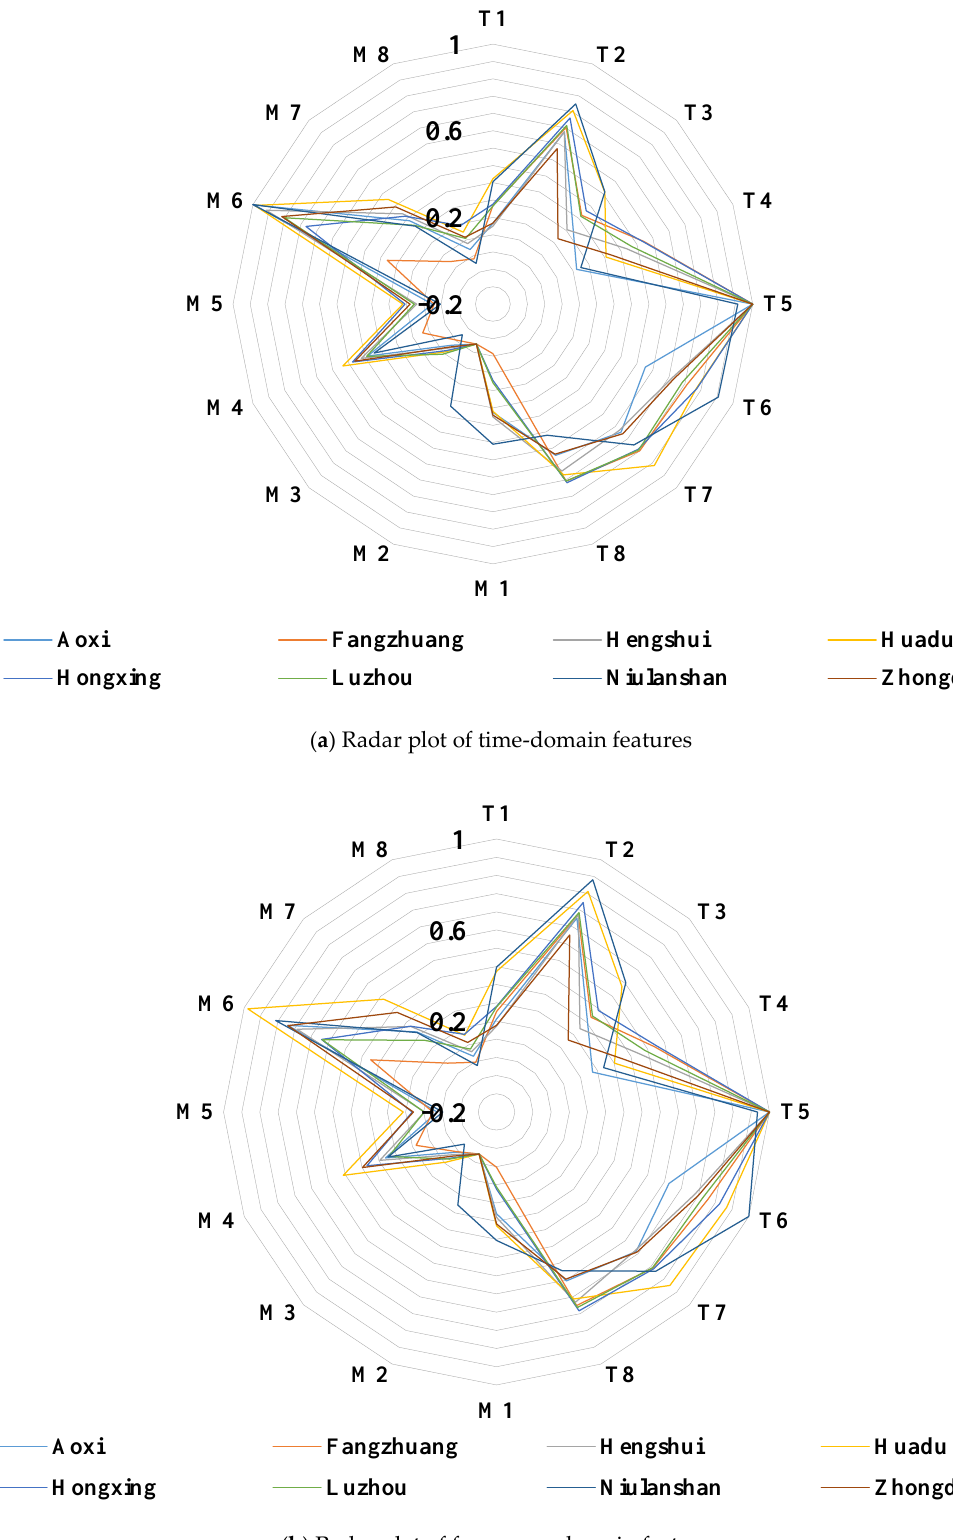
Figure 6. Radar plot for different kinds of Chinese liquors.